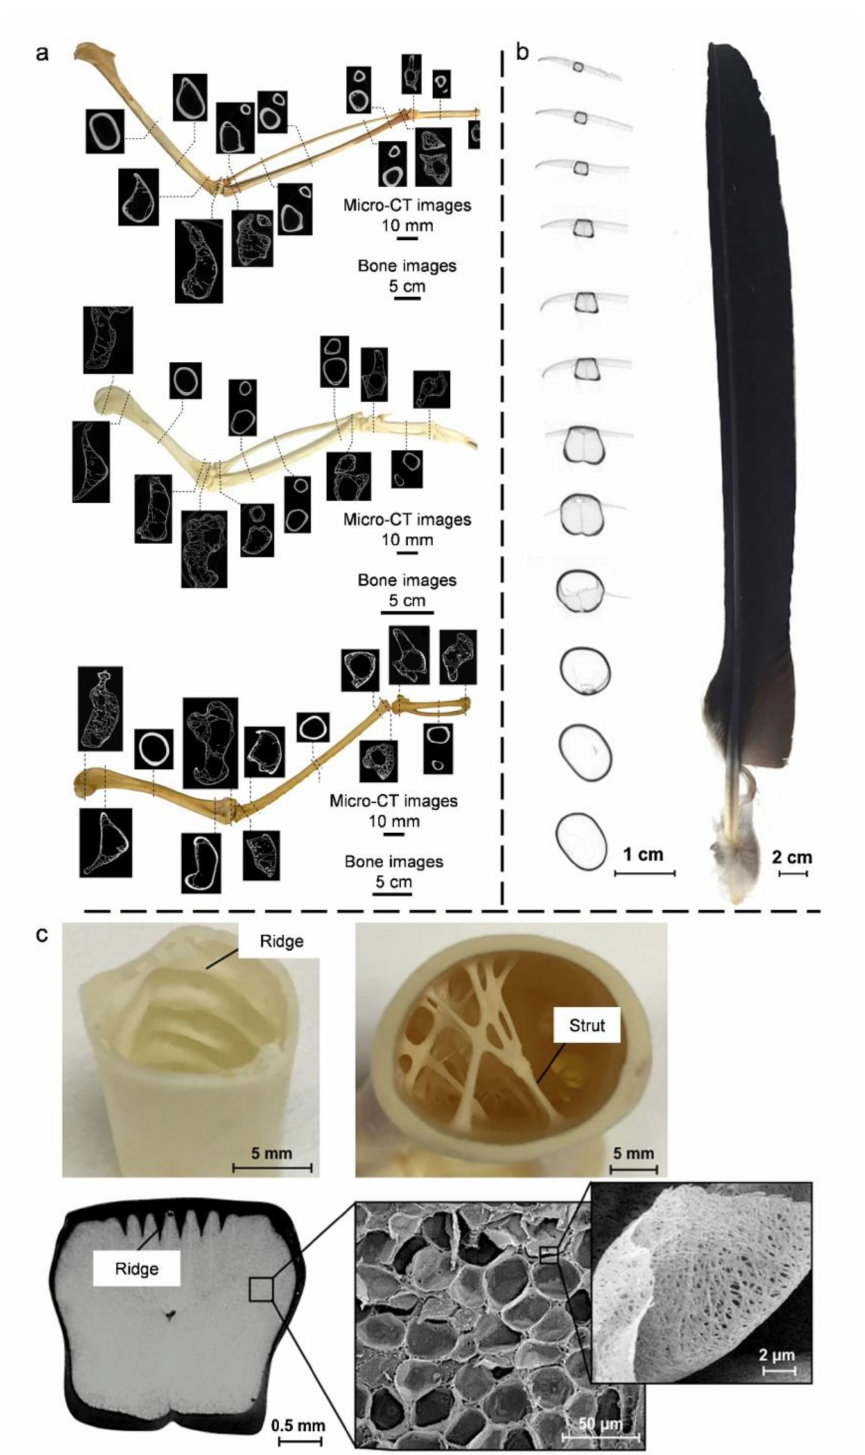
during bending. There are ± 45 ◦ cross-fiber layers on the lateral walls of the rachis to cope with the shear stress caused by bending and improve the torsional stiffness [106–108].